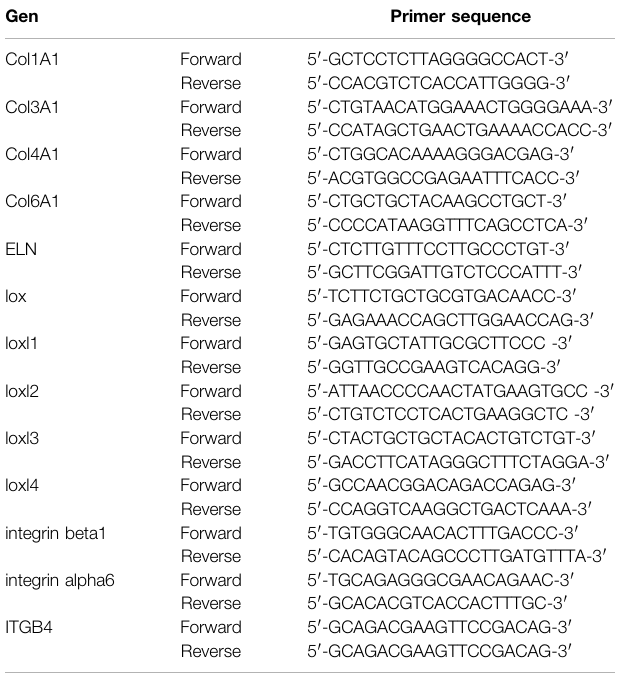
TABLE 1| Sequencesofforward andreverse primersofselectedgenesdesigned for RT-PCR. Gen Primer